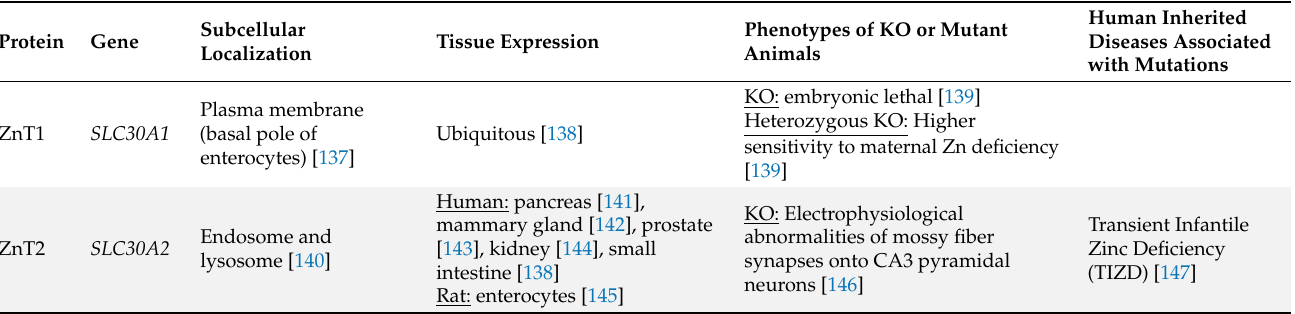
Table 3. Mammal ZnT proteins, phenotypes of KO or mutant animals and human inherited disorders associated with their